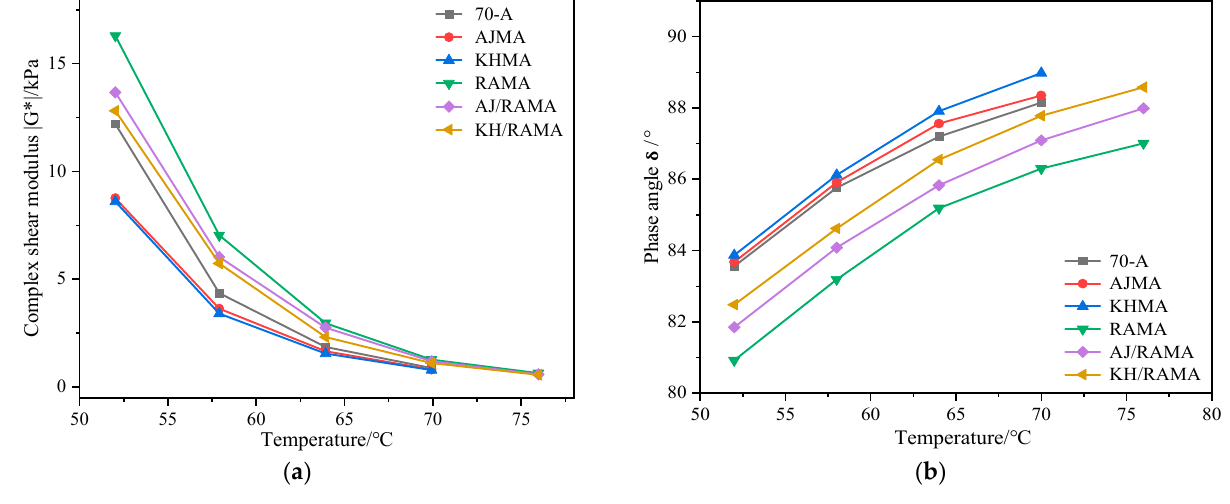
Figure 3. ( a ) Complex shear modulus; ( b ) Phase